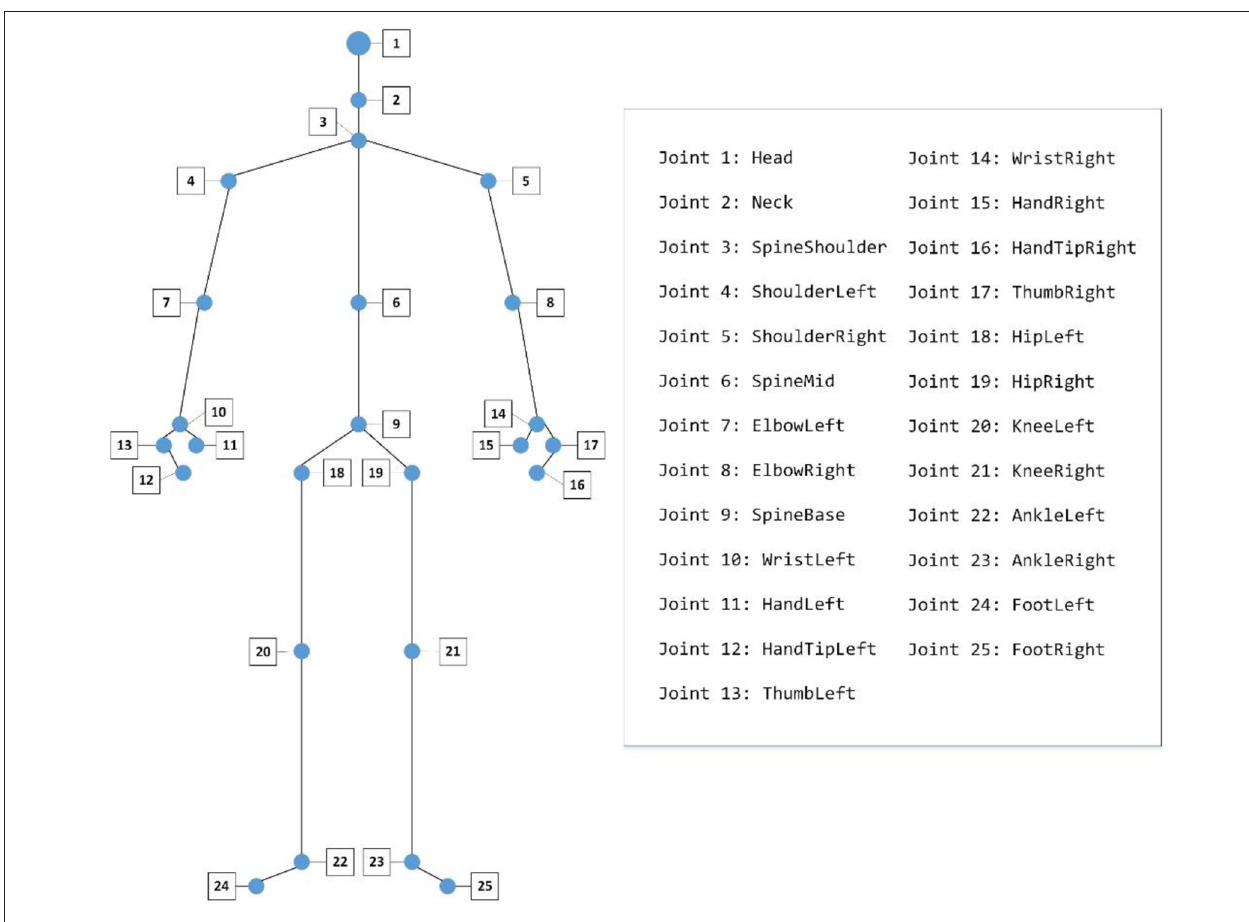
FIGURE 2 | The 25 joints captured by a Kinect.